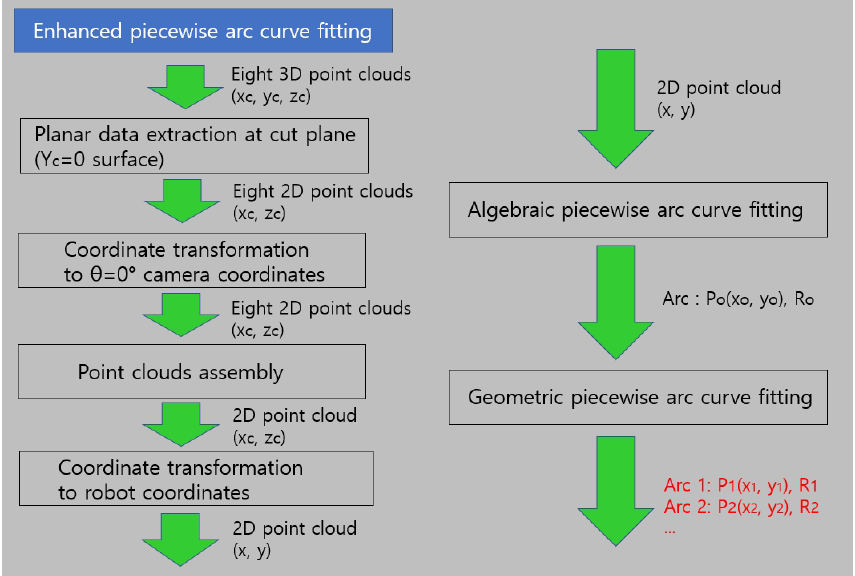
Figure 3. The enhanced piecewise arc curve fitting